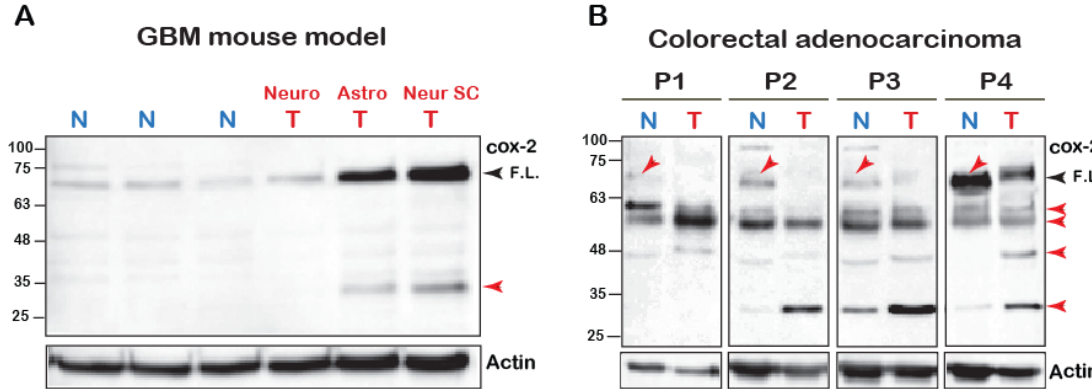
Figure 1. COX-2 fragments in cell lines and human samples. ( A ) 100 μg of total tissue homogenates of brain samples of glioblastoma multiforme (BGM) models of transgenic mice were resolved by SDS-PAGE and probed for the presence of COX-2. (Neuro-tumor from neuronal origin, Astro- from astrocyte origin and Neuro SC-from neural stem cells). Black arrowhead marks the full-length (F.L.) COX-2 and the red arrowheads mark the lower fragments. ( B ) Samples of tumors (T) and surrounding seemingly healthy tissues (N=Normal) obtained from four patients diagnosed with colorectal adenocarcinoma were probed for COX-2 expression. Blots show the presence of several immunoreactive bands, some of which are lower than the expected MW of the native protein (Red arrows).